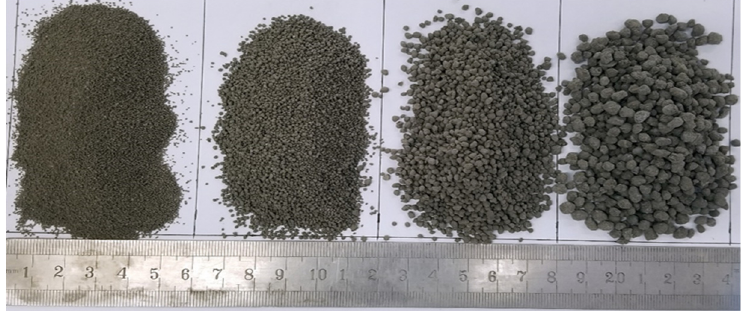
Figure 3. The appearance of CHPs.